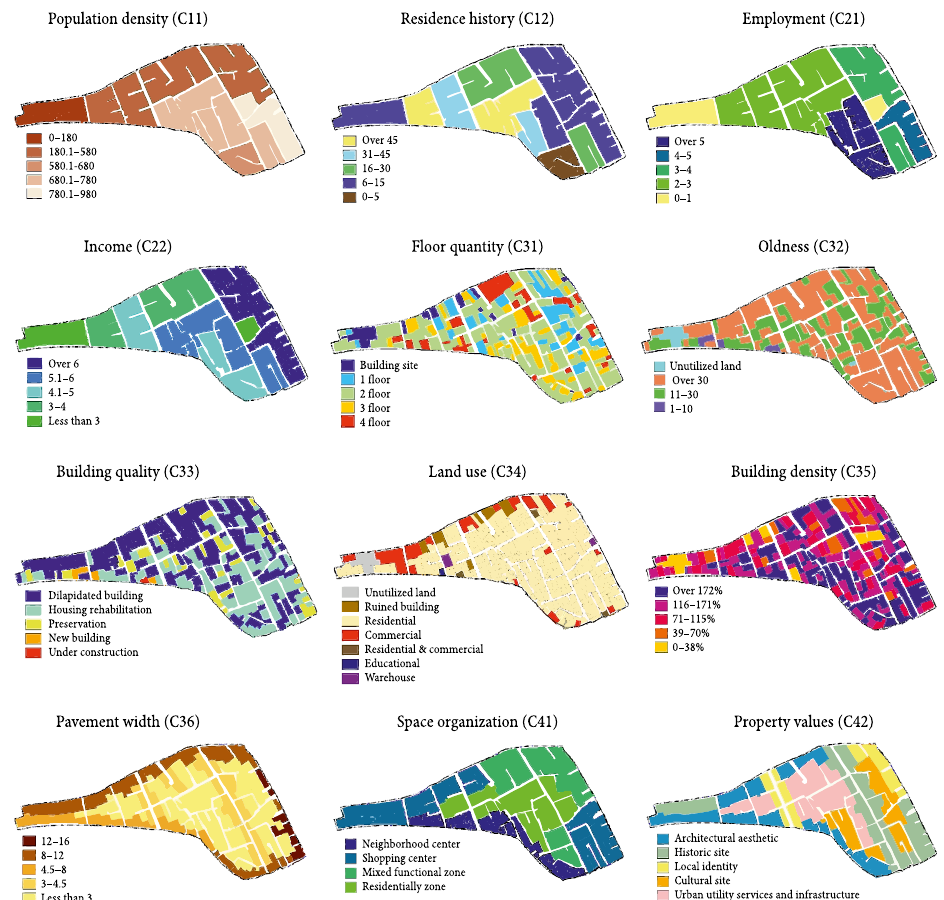
Fig. 2. Maps as input data layers of sub-criteria used for the proposed Fuzzy AHP model